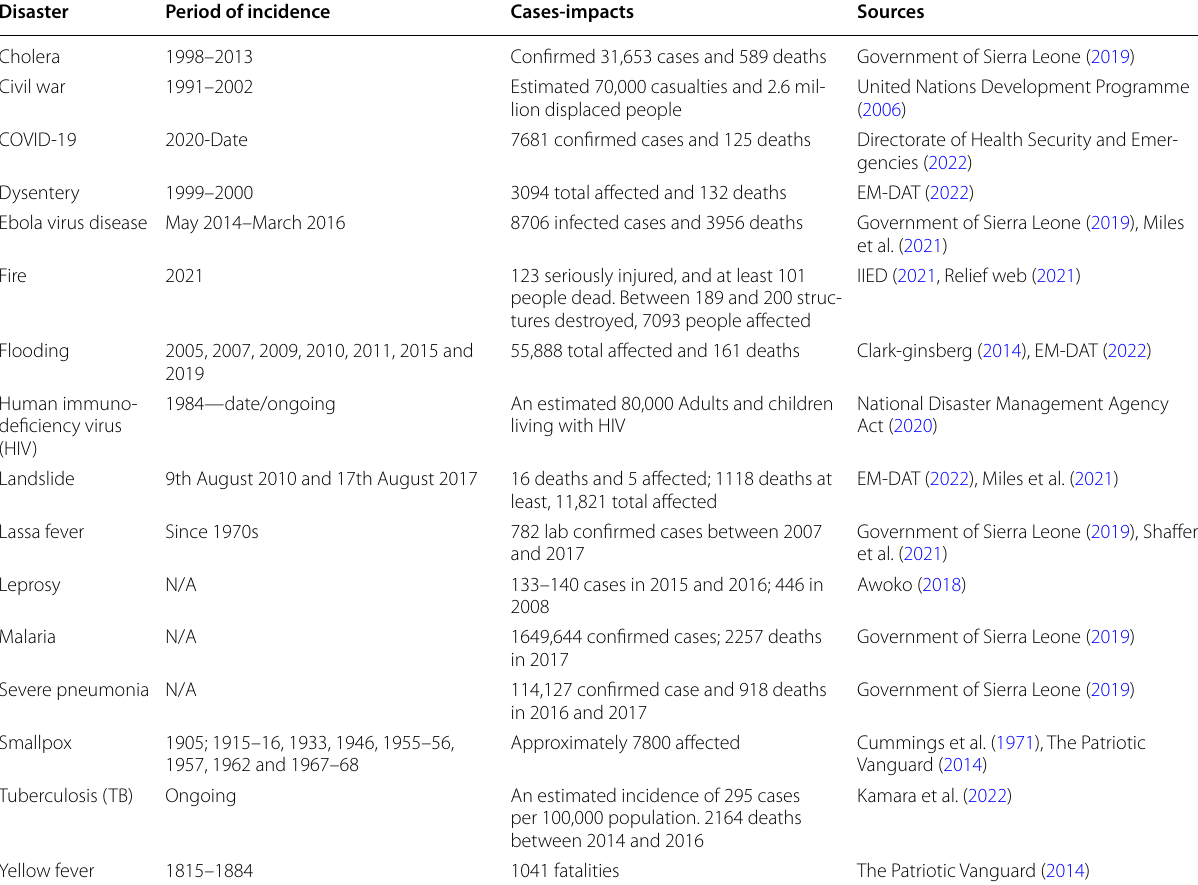
Table 1 A breakdown of disasters in Sierra Leone, period of incidence, impacts, and